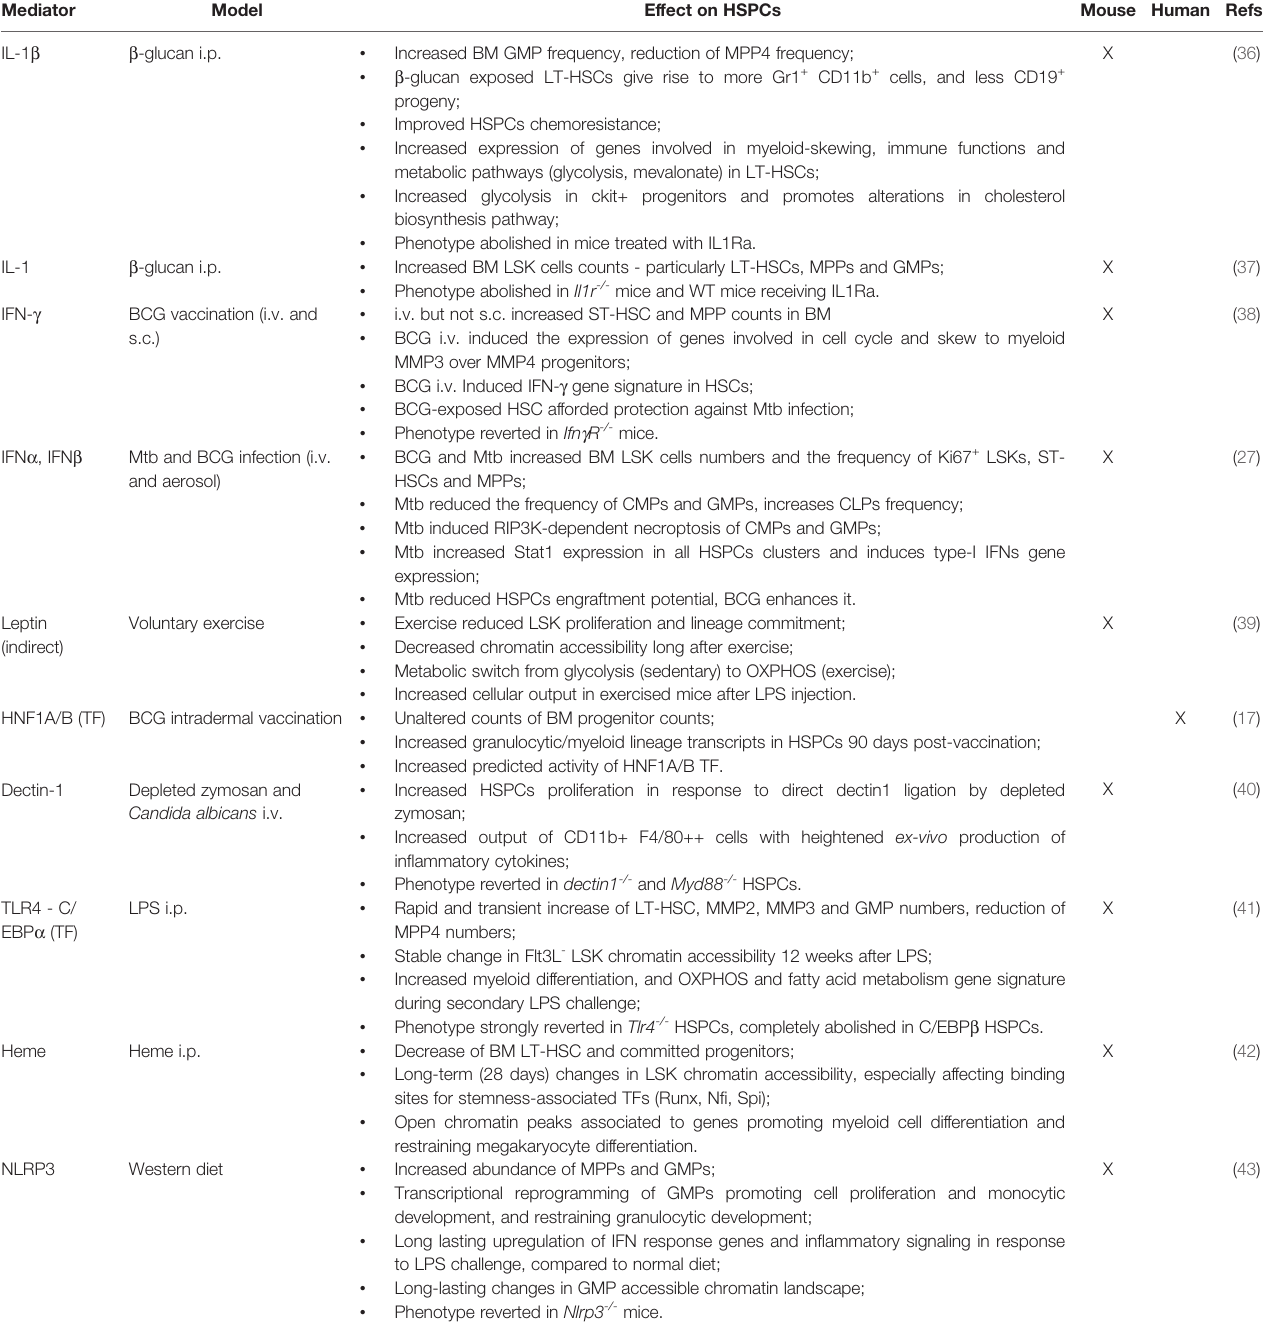
TABLE 1 | Experimental studies demonstrating the direct involvement of HSPCs in the induction of innate immune